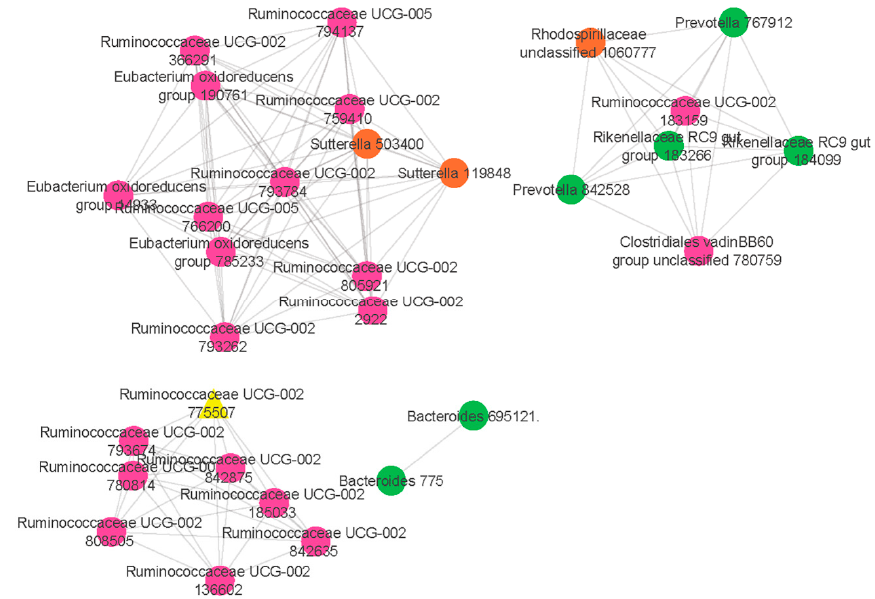
Figure 2. Network analysis identifies a distinct module of co-associated taxa. The highly correlated taxa in the comparisons of food allergic children and non-food allergic children are indicated and colour coded according to the phylum. Green colour represents Bacteroidetes phylum, pink colour represents Firmicutes phylum while orange colour represents Proteobacteria phylum. Hub taxon (yellow triangle) exhibits greatest intramodular connectivity, whereas connector taxa (circles) exhibit a higher frequency of intramodular